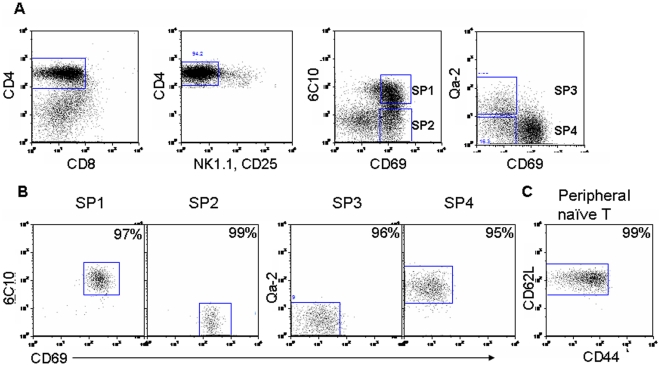
Isolation of CD4+ single positive thymocyte subsets and CD4+ naïve T cells from lymph nodes.(A–B) Thymocytes pooled from 15–20 mice were treated with anti-CD8 (3.155) mAb and complement. Viable cells were then separated by density centrifugation and stained with mAbs against mouse CD4, CD8 (53-6.7), CD69, and 6C10 or Qa-2. To exclude the contamination of NKT and Treg cells, PE-conjugated anti-NK1.1 and anti-CD25 antibodies were included in the mixture of staining Abs. CD4+CD8-CD25-NK1.1- medullary thymocytes were gated (A) and sorted into the four subsets (B) defined in the text (i.e., SP1–SP4). The numbers in the top-right corners indicate the purity of the sorted cells. (C) Brachial, mesenteric, and inguinal lymph nodes were pooled from 5 to 8 mice and stained with mAbs against mouse CD4, CD8, CD44, CD62L, NK1.1, and CD25. CD4+CD8-CD44lo/intCD62LhiCD25-NK1.1- naïve cells were sorted. The number indicates the purity of the sorted cells.